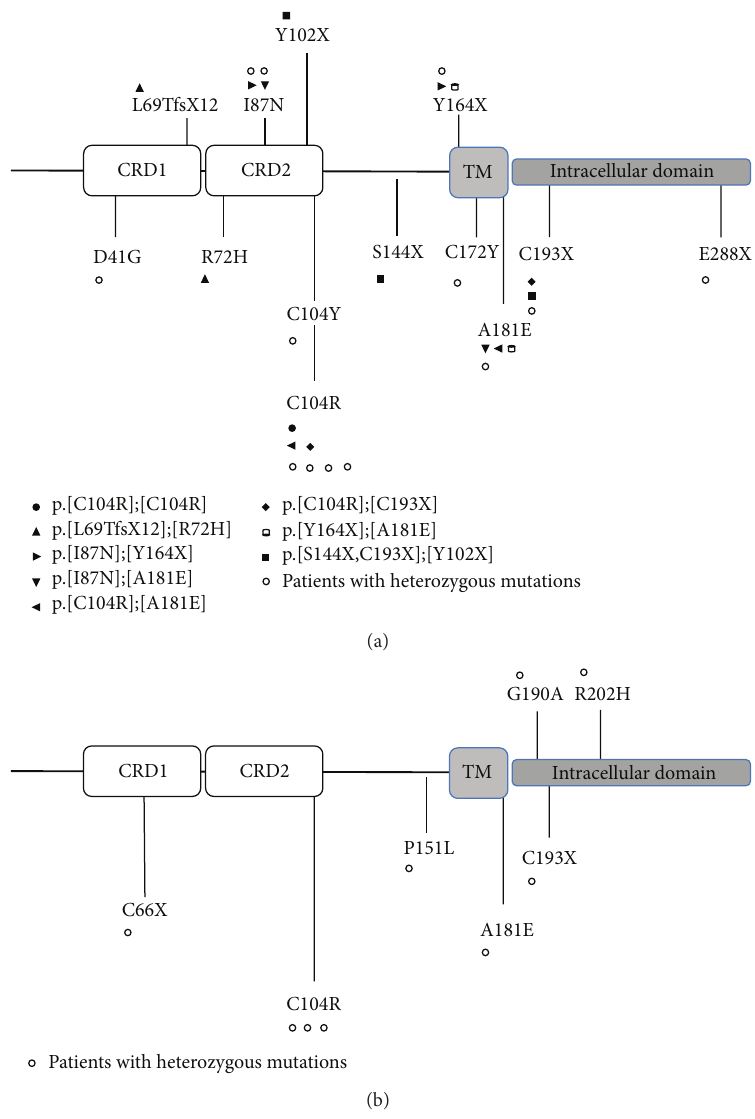
Figure 1: Distribution of TNFRSF13B mutations across the TACI protein in 21 of 189 patients with CVID (a) and in 9 of 67 patients with IgAD (b). Each symbol represents one patient. e indicates patients with homozygous TNFRSF13B mutations; ∘ represents patients with heterozygous TNFRSF13B mutations. Compound heterozygous mutated TACI-deficient patients are labeled as indicated in the figure. CRD1 and CRD2 indicate cysteine-rich domains (residues 32–68 and 69–107); TM, transmembrane domain (residues